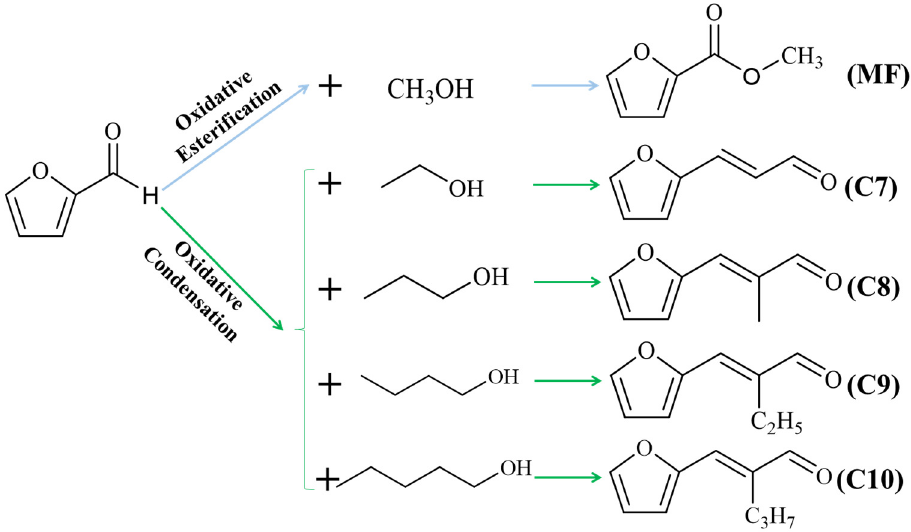
Figure 1. Schematic diagram reactions of furfural with aliphatic alcohols via oxidation processes.